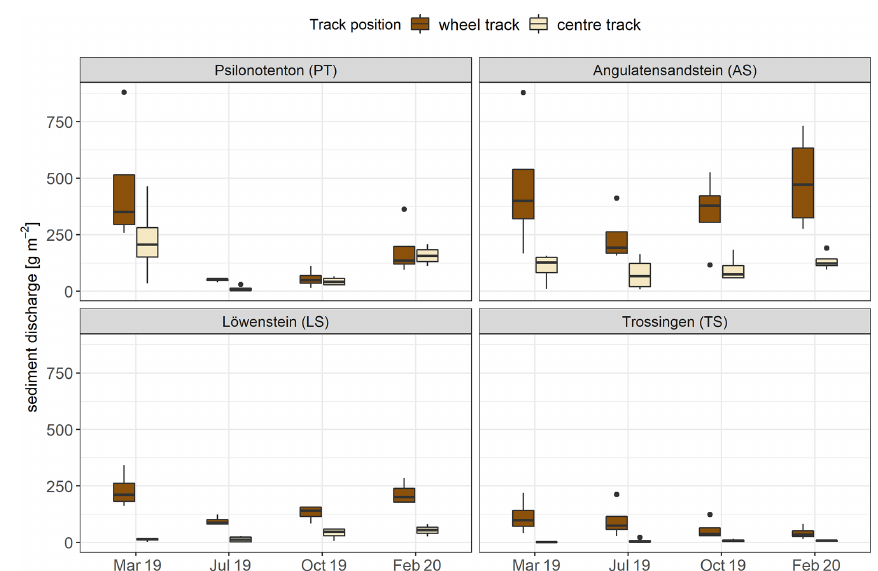
Figure 5. Sediment discharge during simulated rainfall in the wheel track ( n = 4) and centre track ( n = 4) of the four skid trails for every rainfall simulation time. The bottom and top of the box represent the first and third quartiles, and whiskers extend up to 1.5 times the interquartile range (IQR) of the data. Outliers are defined as more than 1.5 times the IQR and are displayed as dots.